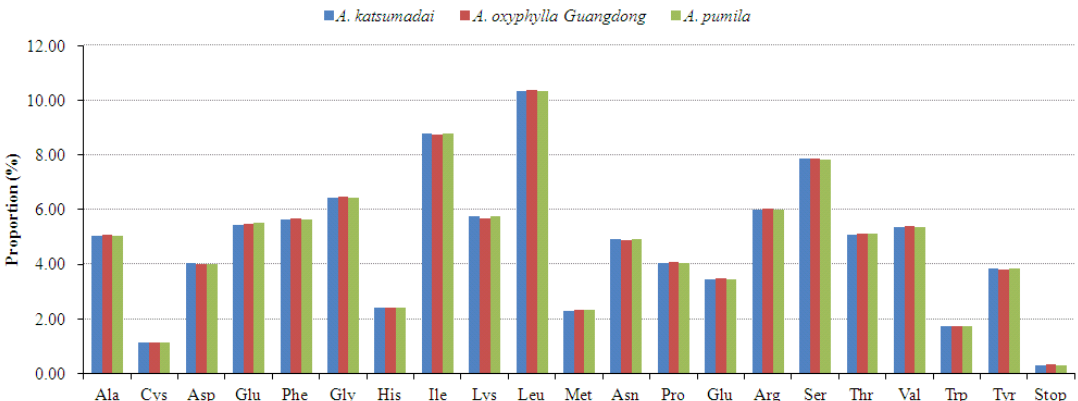
Figure 2. Amino acid proportion in three Alpinia species protein-coding sequences.